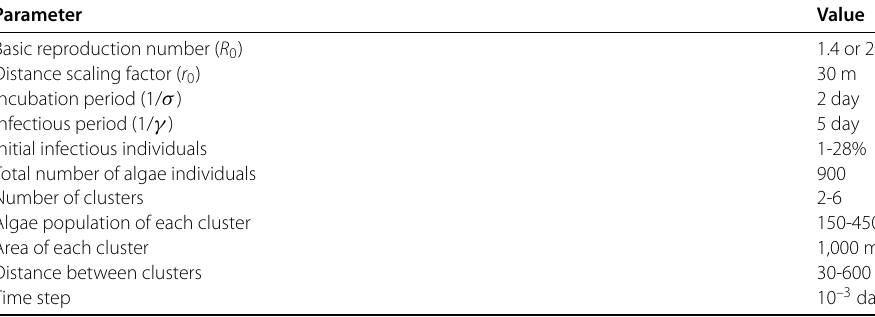
Table 1 Parameter values used in the simulations